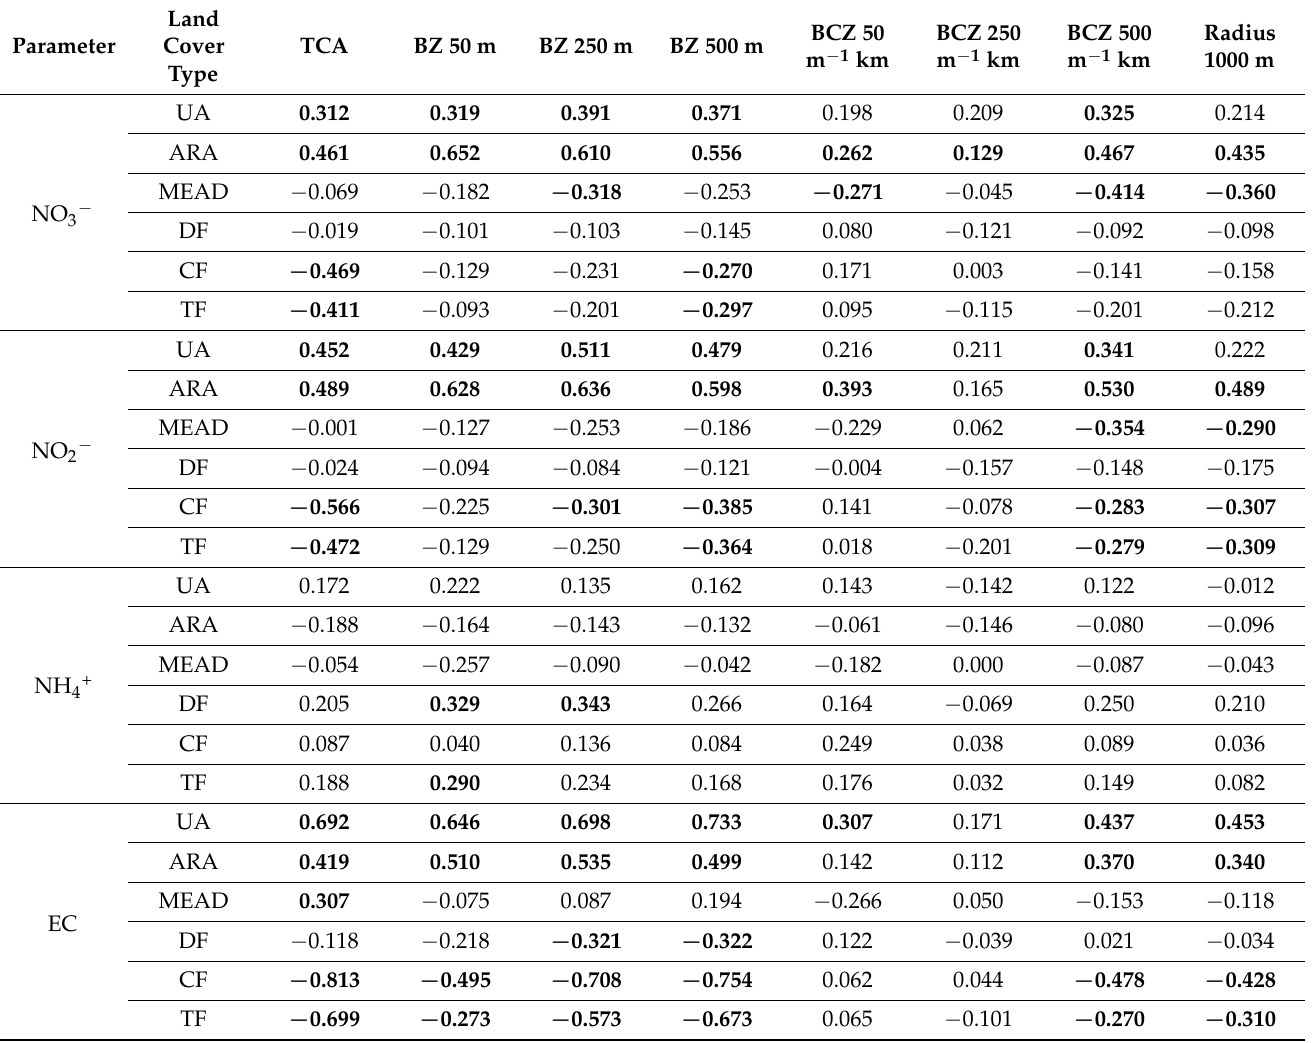
Table 3. Spearman rank correlation coefficients linking selected land cover metrics from the streams during the study period. Abbreviations are the same in comparison with Table 2. The bold type indicates a statistically significant correlation at p =